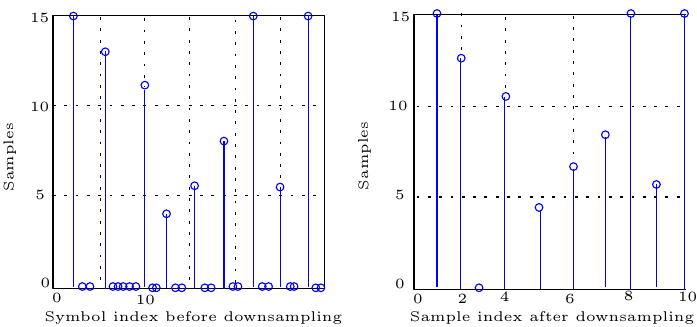
Figure 3. Time domain plot of signal decimation for M = 2.